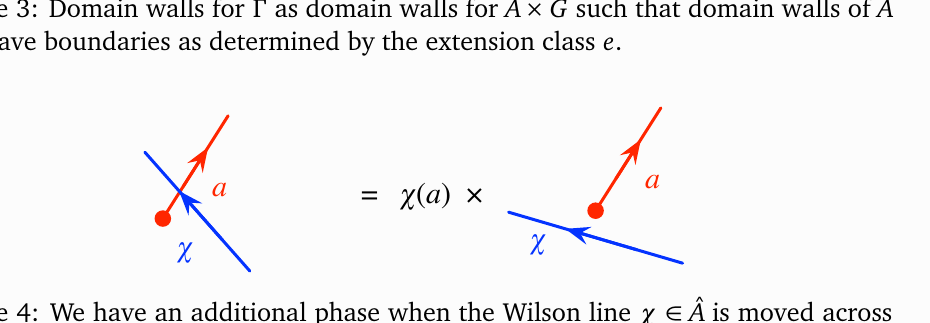
Figure 4: We have an additional phase when the Wilson line χ ∈ ˆ A is moved across the boundary of the domain wall labeled by an element of A .